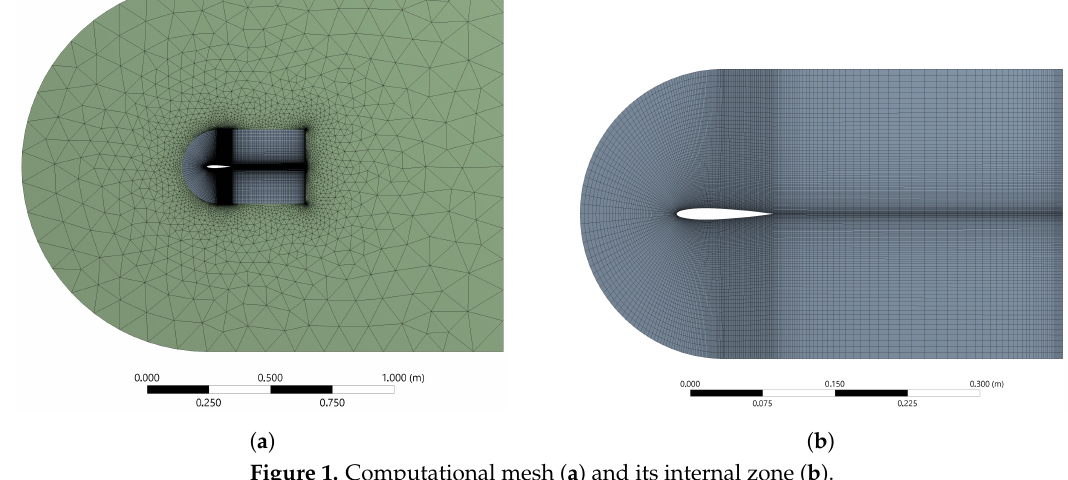
Figure 1. Computational mesh ( a ) and its internal zone ( b ).